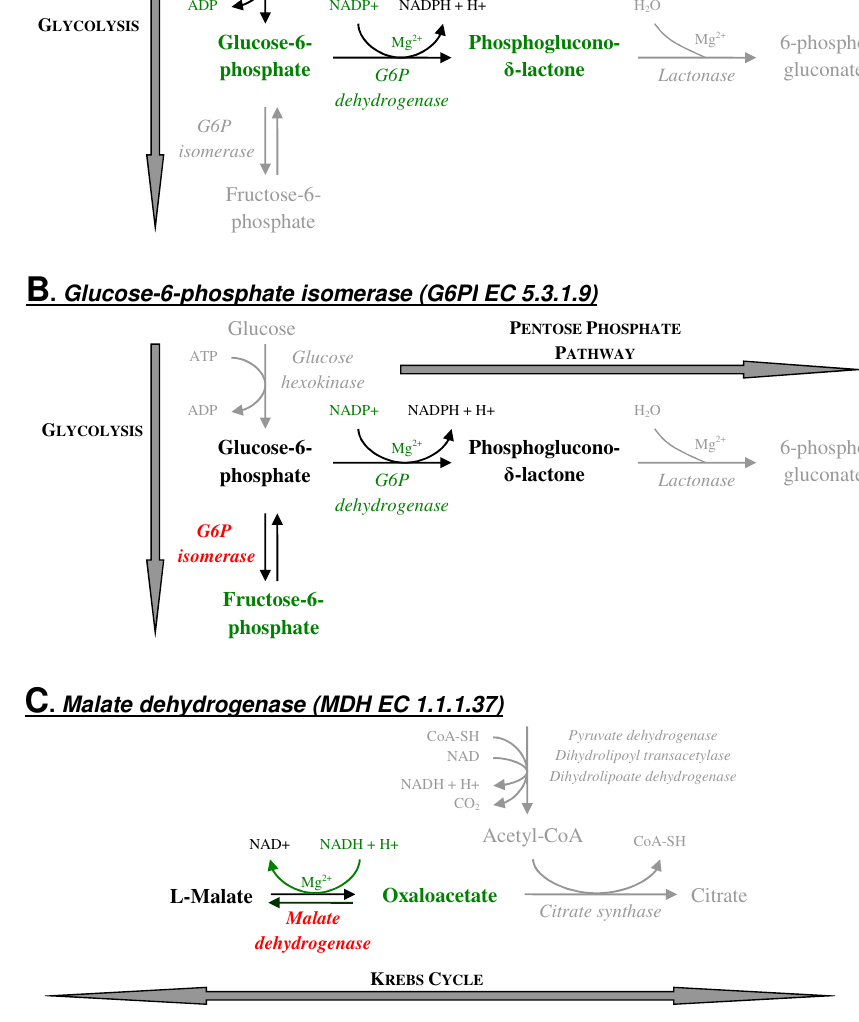
Fig. 1. Enzymatic reactions mediated by the two enzymes involved in glycolysis ( (A) GHK: glucose hexokinase, (B) G6PI: glucose-6- phosphate isomerase) and the enzyme involved in the Krebs cycle ( (C) MDH: malate dehydrogenase) used to quantify the protective role of soil particles on respiratory enzymes. This protective role was studied in the non-irradiated-soil from Theix. The principle of the enzymatic activity measurement was to set up a system of enzymatic reactions where the studied enzyme (red) was the limiting factor. For doing this, we added all substrates, cofactors and intermediary enzymes in excess (green). The activity of the studied enzyme (GHK, G6PI, MDH) was quantified by measuring the formation or the consumption of NADH by spectrometry. Reactions surrounding the studied enzymatic (grey) are given for